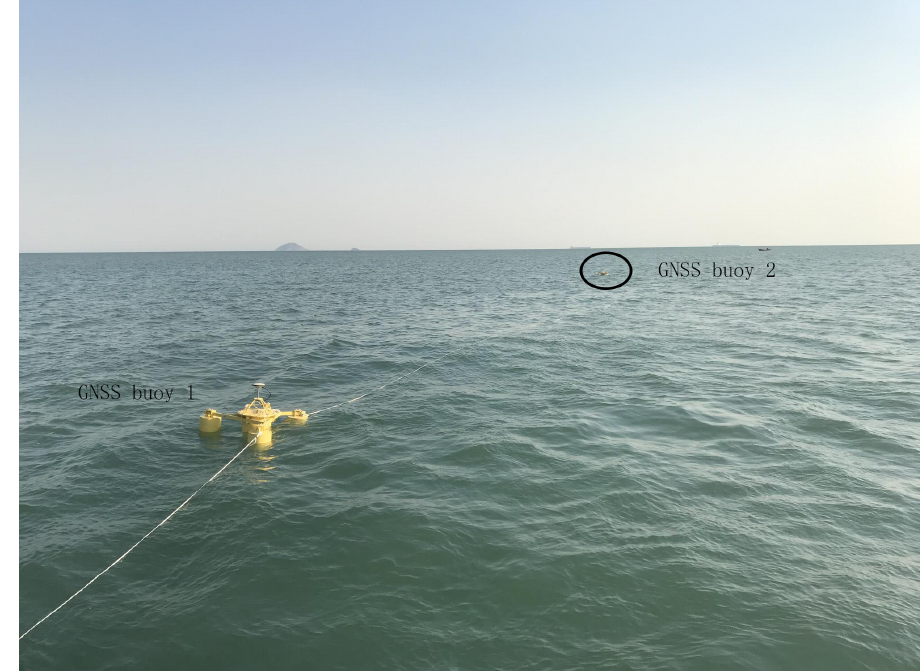
Figure 7. The GNSS buoys tethered at the same location close to the station XMD tide gauge for cross-validation